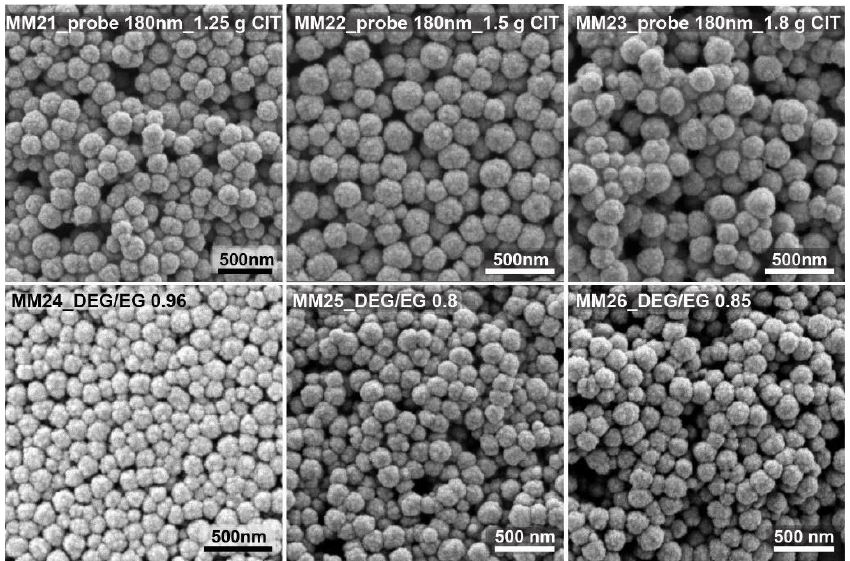
Figure 3. In the top three SEM images, nanocrystal clusters were prepared with a citrate amount varied between 1.25 and 1.8 g, with a constant DEG/EG ratio equal to 1. In the bottom three SEM images, nanocrystal clusters were prepared by changing the solvent ratio between 0.75 and 0.85, with a constant citrate amount of 3 g. The nanocrystal cluster size was found to be 180 nm plus/minus 20 nm.